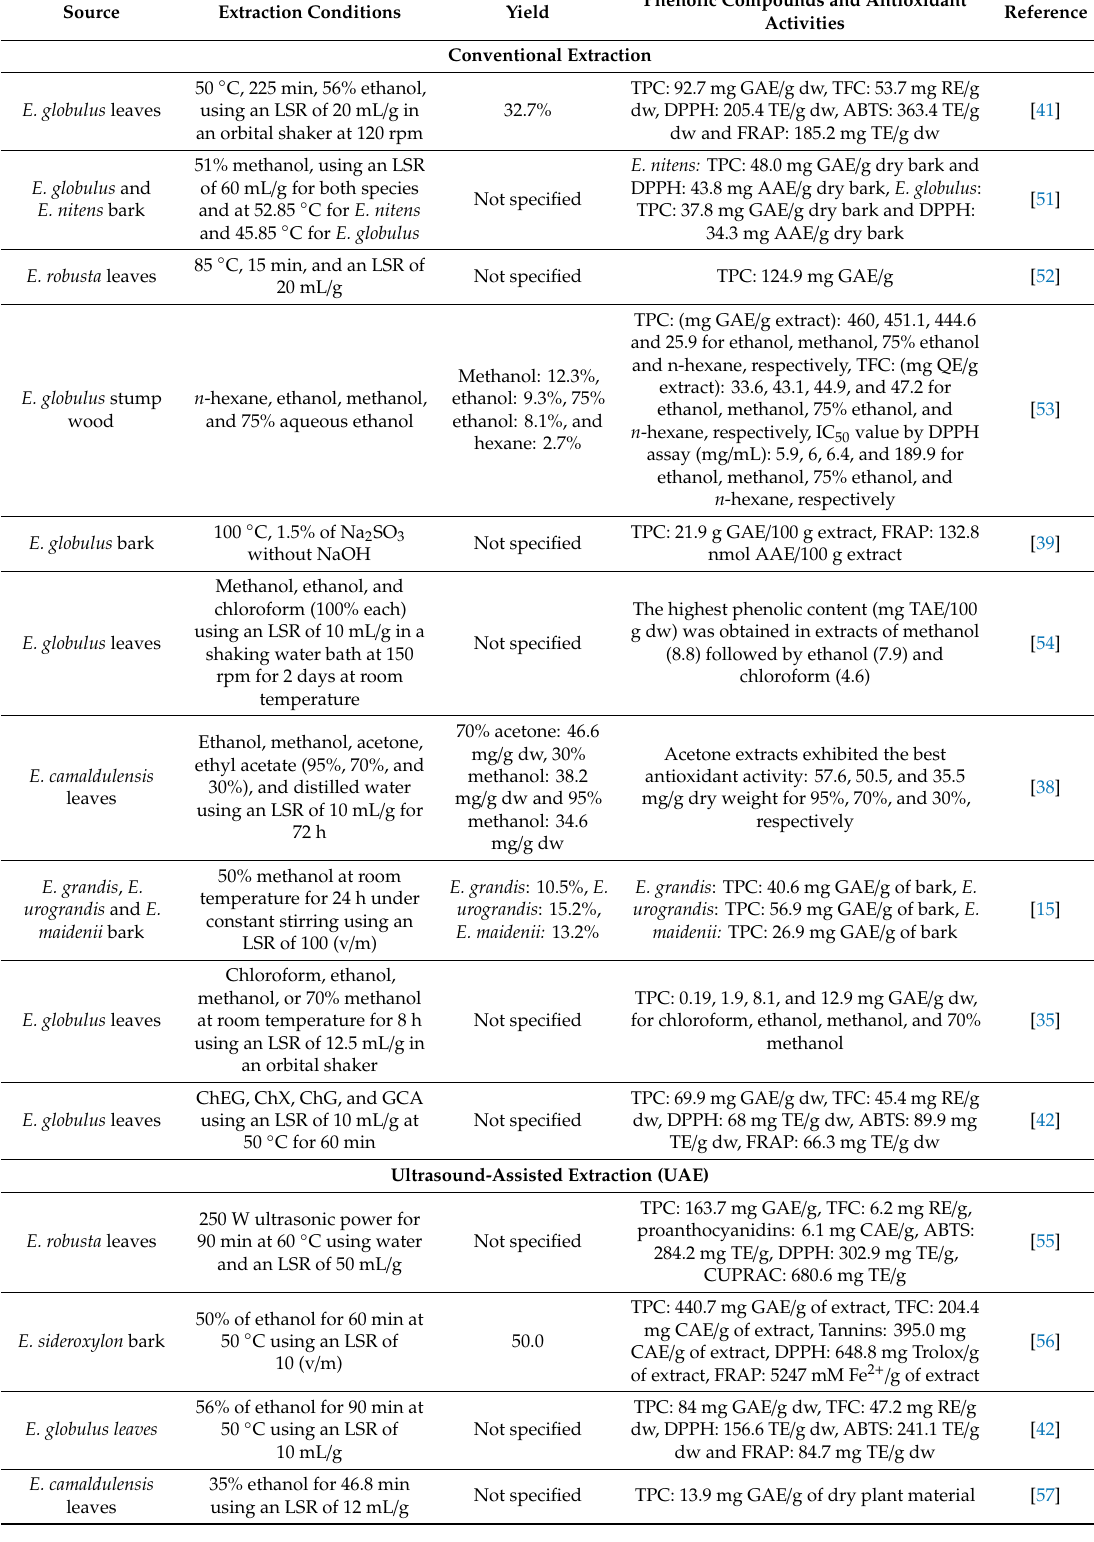
Table 2. Extraction technologies for obtaining phenolic compounds from Eucalyptus